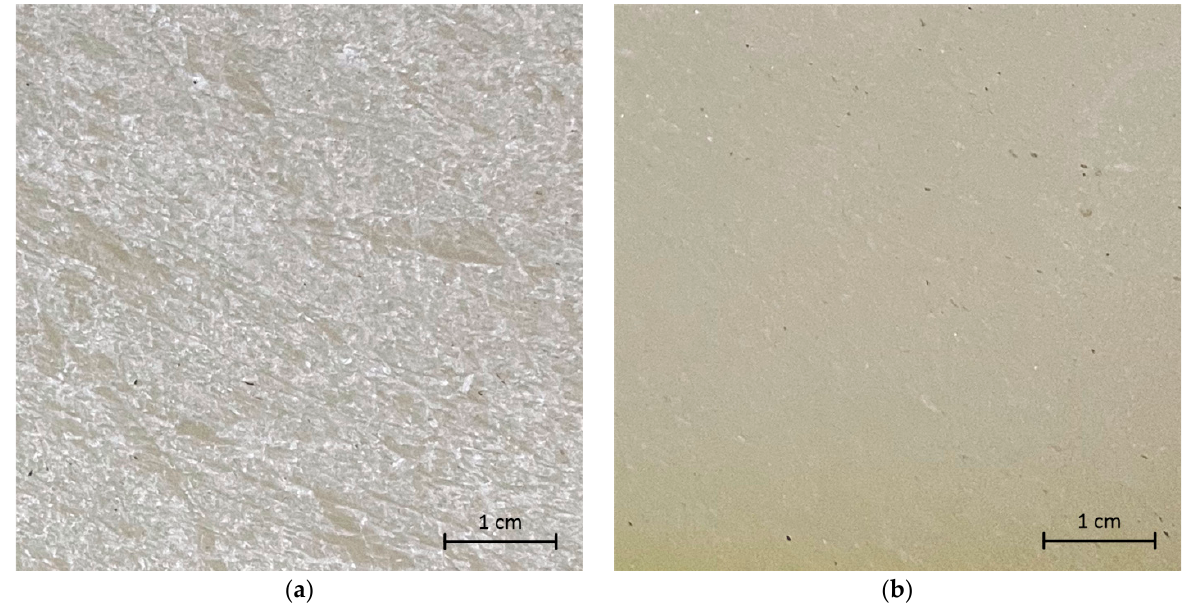
Figure 2. Photographs of a section of a Teflon (PTFE) cutting board with damage before coating ( a ) and after the application and drying of the PTFE/Ag 2 O-NPs 0.1% composite coating ( b ). To assess the microrelief of the treated surface, the samples were analyzed using the AFM method. Fluoroplastic without the addition of NPs after drying forms a smooth surface without cracks, protrusions, or other inhomogeneities (Figure 3a). The difference in the height of the sample section with an area of ~1 μ m2 did not exceed 2–3 nm (Figure 3c).